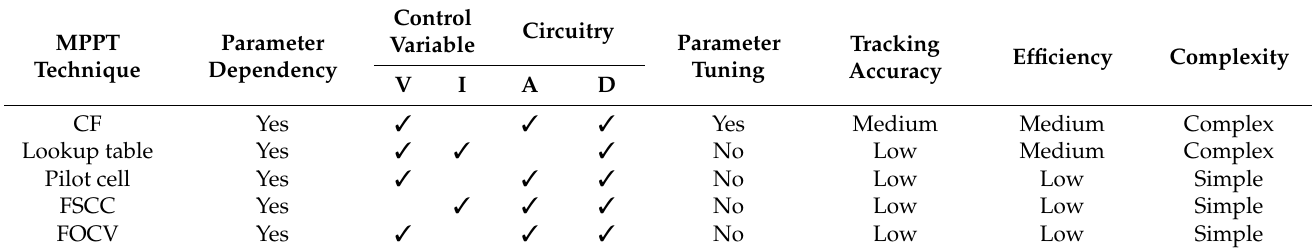
Table 1. A comparison of various offline MPPT methods.